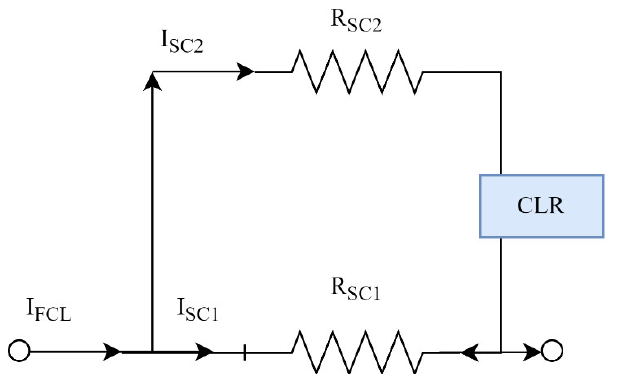
Figure 5. DC superconducting fault current limiter (SFCL).